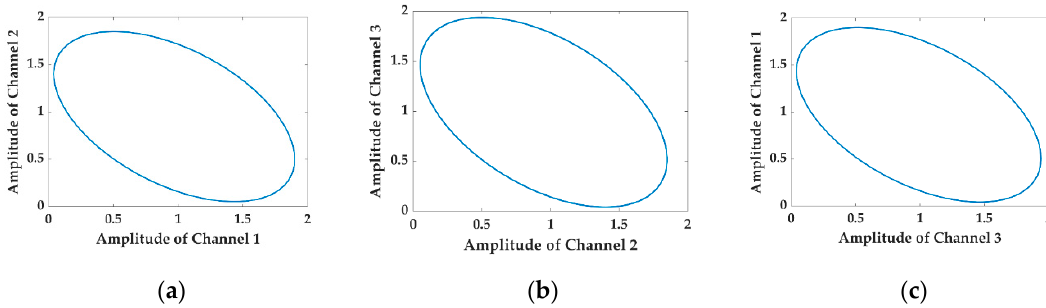
Figure 1. Numerical results obtained from Equation (1), in which the auxiliary amplitude modulation (AAM) of the light source is neglected: standard ellipses. ( a ) The Lissajous figure (LF) drawn with Channel 1 and Channel 2; ( b ) the LF drawn with Channel 2 and Channel 3; ( c ) the LF drawn with Channel 3 and Channel 1.